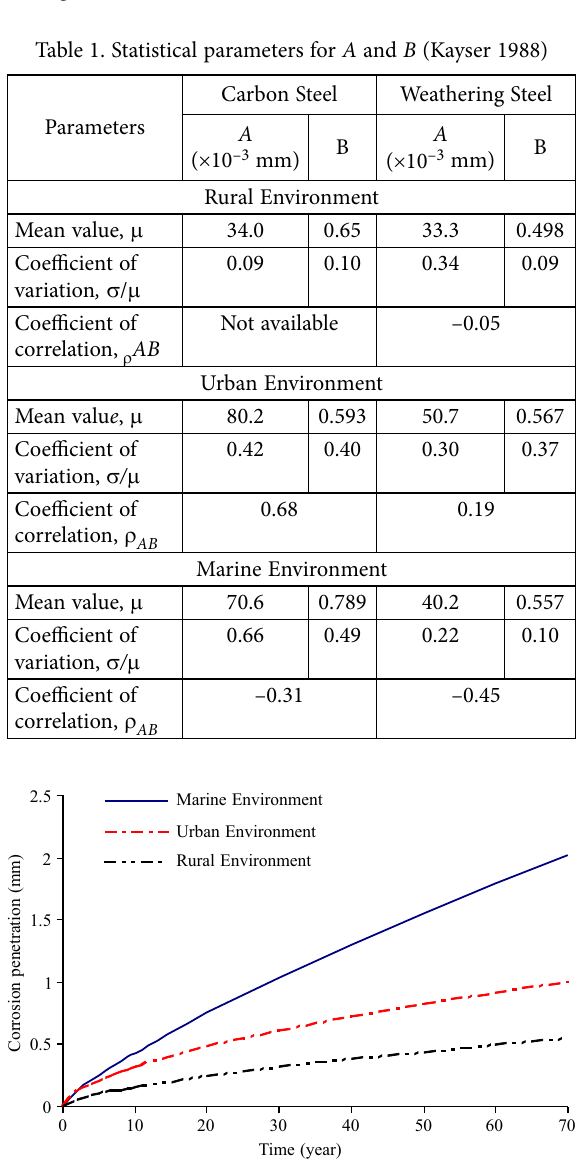
Fig. 2. Corrosion penetration versus time for carbon steel in various environments (Kayser 1988)